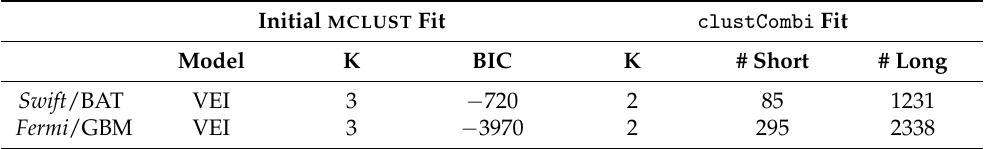
Table 2. Number of components (K), Bayesian Information Criterion (BIC) values, models, and number of bursts (#) identified in the MCLUST and subsequent clustCombi fits to the Swift /BAT and Fermi /GBM samples.